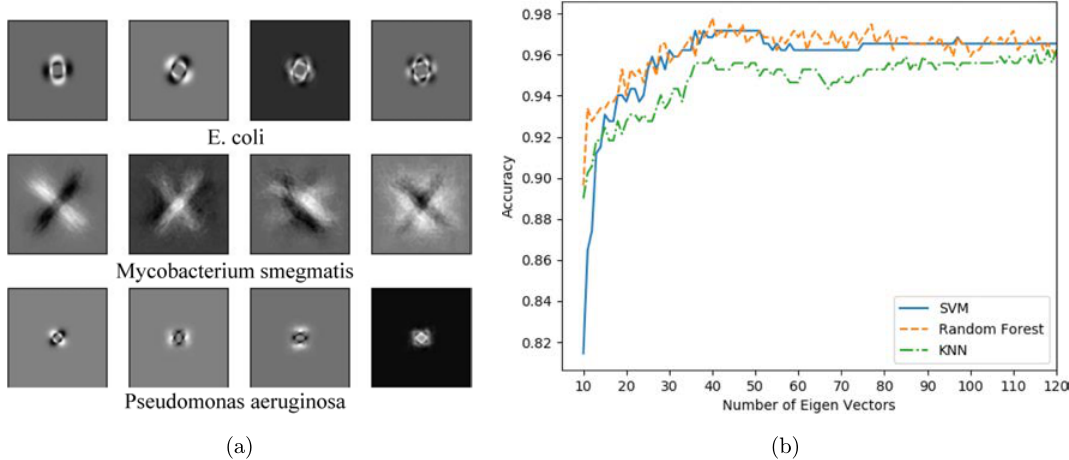
Fig. 4. (a) The representative eigenvectors of the bacteria and (b) the relationship between the number of eigenvectors and the classi¯cation accuracy.